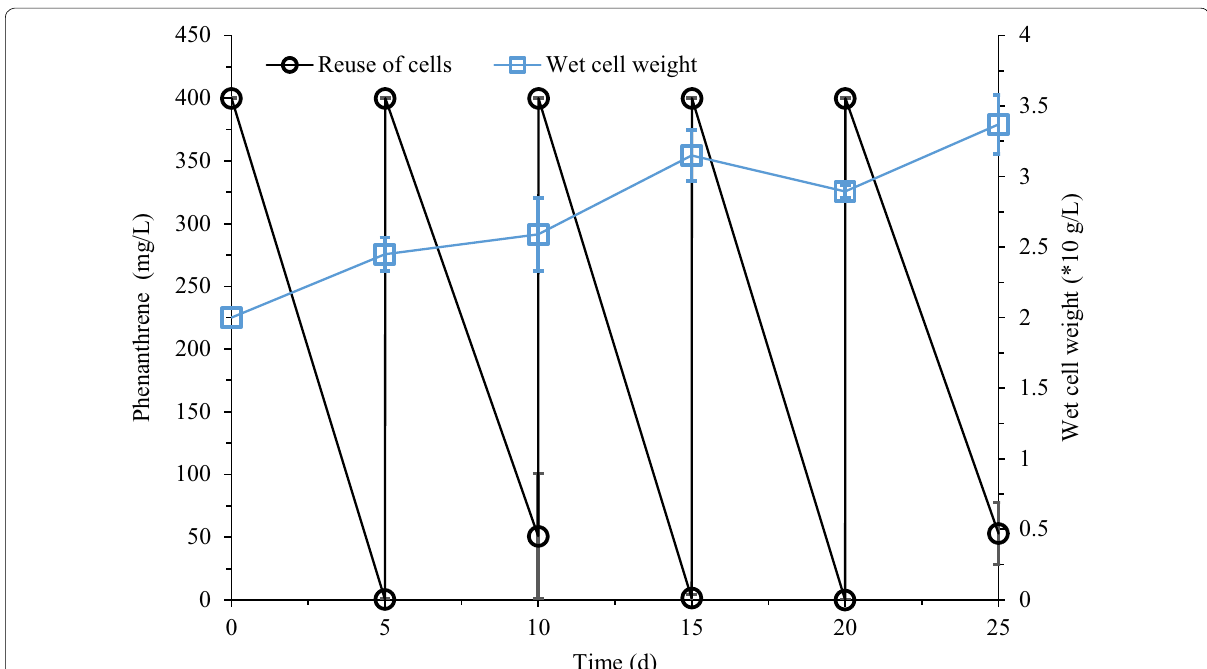
Fig. 5 Reuse of cells alone for phenanthrene biodegradation. S. polyaromaticivorans was inoculated into 30 mL LB medium in a 150-mL flask and cultured at 30 °C and 160 rpm for 18 h. Cells were collected and then inoculated in CPS to degrade phenanthrene for 5 days. Subsequently, cells were recovered every 5 days and added to a fresh CPS containing 400 mg/L phenanthrene